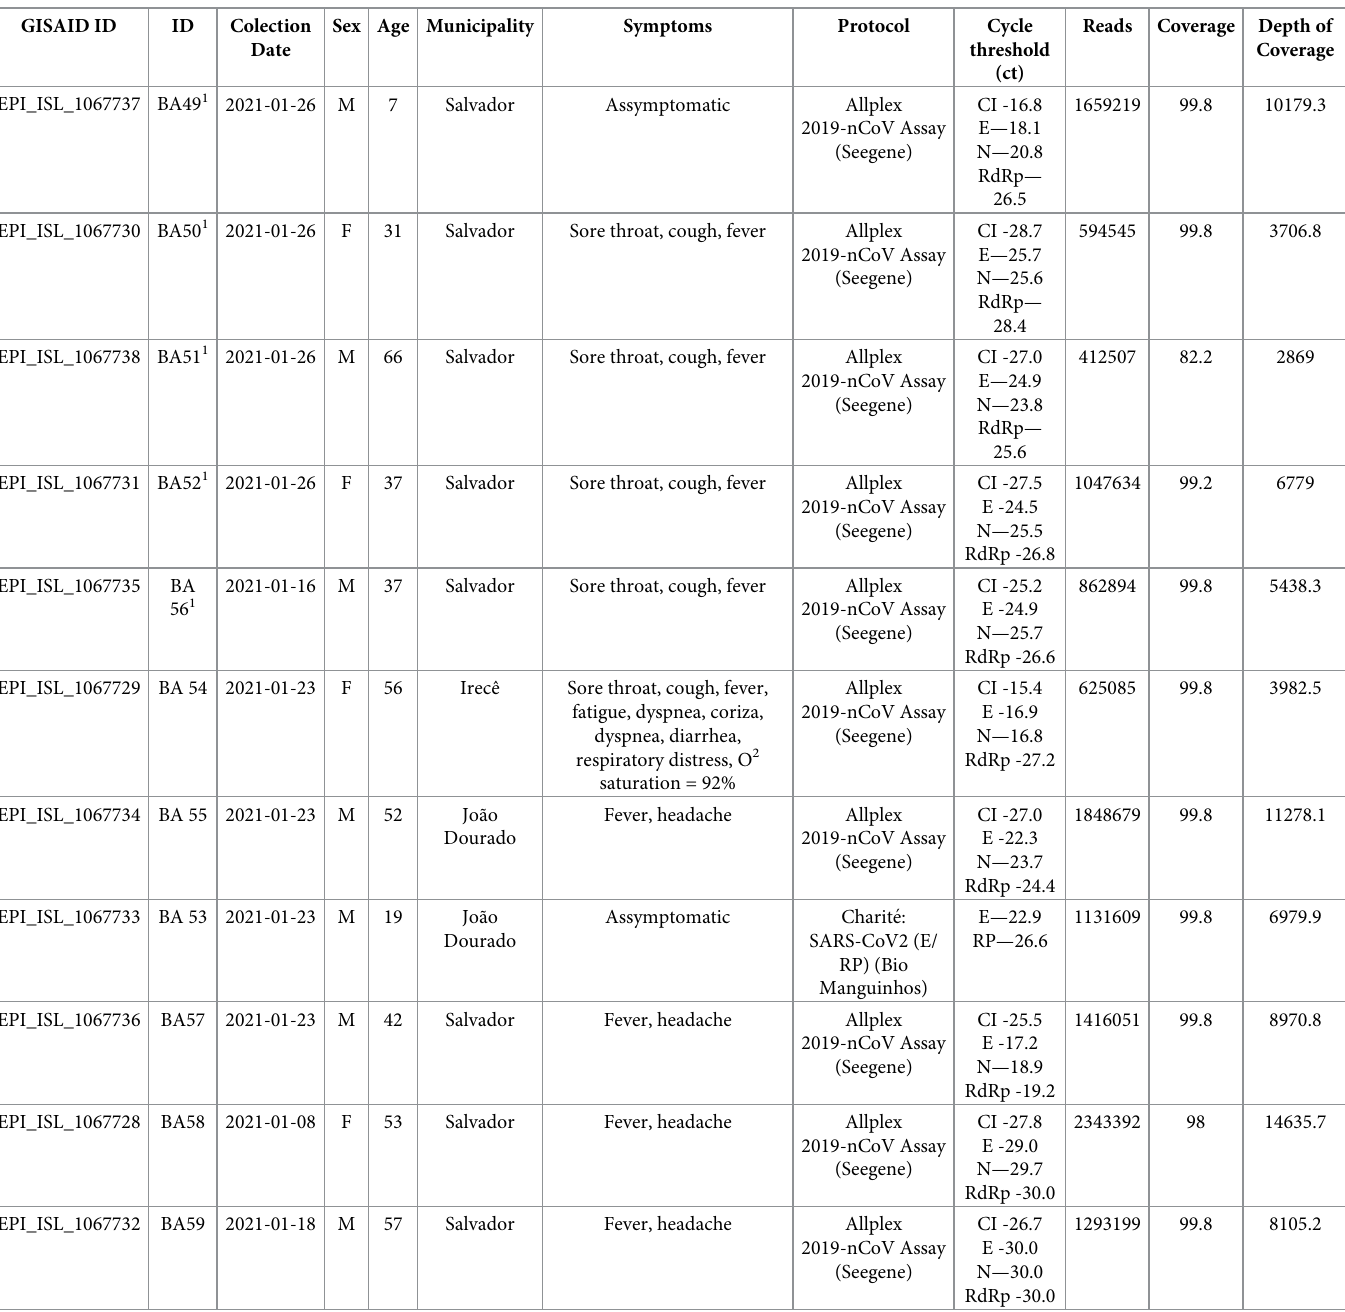
Table 1. Information from patients with travel history from Manaus, Amazonas to state of Bahia. GISAID